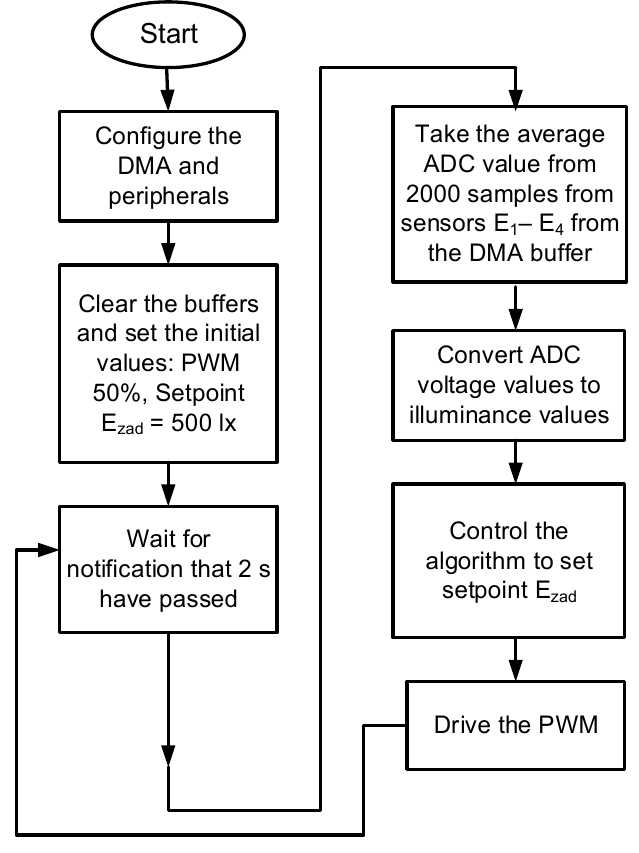
Figure 5. Target loop